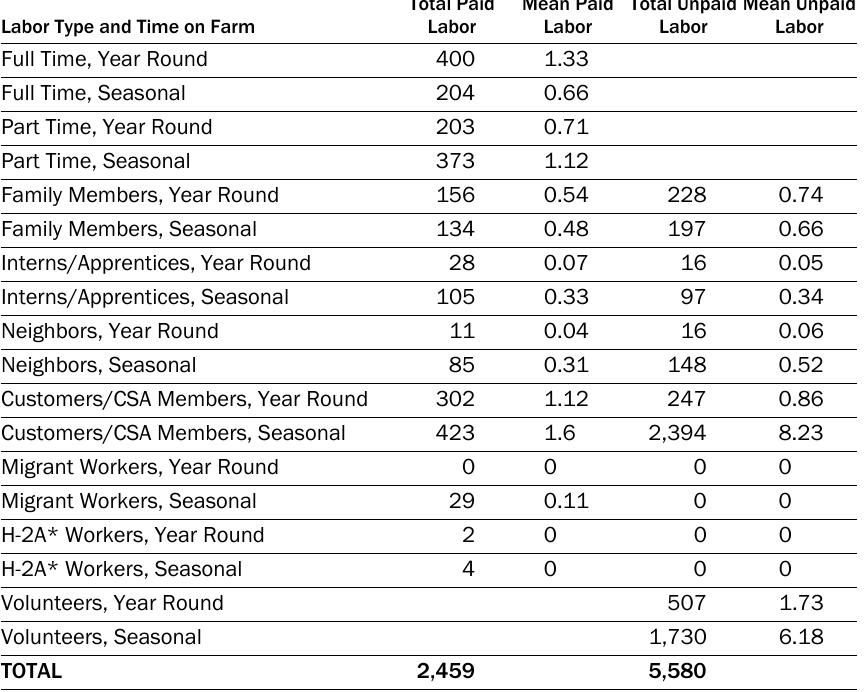
Table 2. Total Number and Mean Number per Farm of Laborers by Type, Paid and Unpaid Laborers ( N